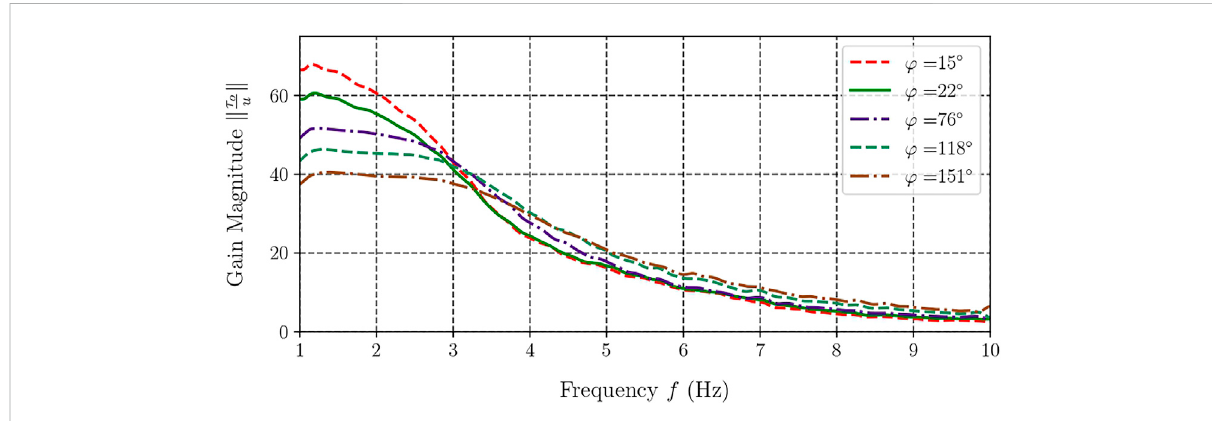
FIGURE 6 Frequency response of the gain from motor torque to handle torque.